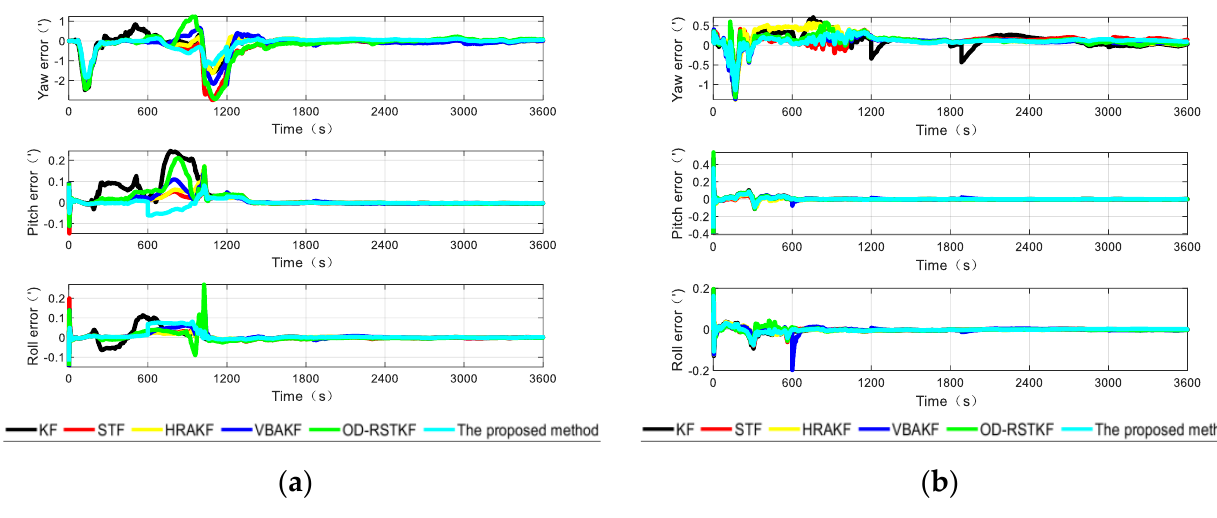
Figure 11. The attitude angle errors from different algorithms in two segments ( a ) The heading angle error of different algorithms in the first test; ( b ) The heading angle error of different algorithms in the second test.